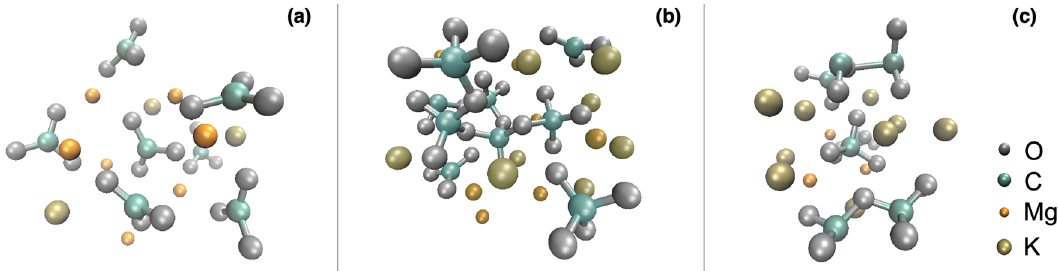
Fig. 2 Atomic structural snapshots from AIMD simulations of K 2 Mg(CO 3 ) 2 at different pressures. a 4.5 GPa, only CO 3 groups. b 106 GPa, co-existing CO 3 and CO 4 units. c 145 GPa, all CO 3 groups have been converted to tetracarbonate. Note that (C 2 O 7 ) 6- dimers are present already at 106 GPa ( b ) (corresponding to 79 GPa in the experimental spectrum, Fig. 1a). The entire supercell con fi gurations at different pressures are shown in Supplementary Fig. 2.